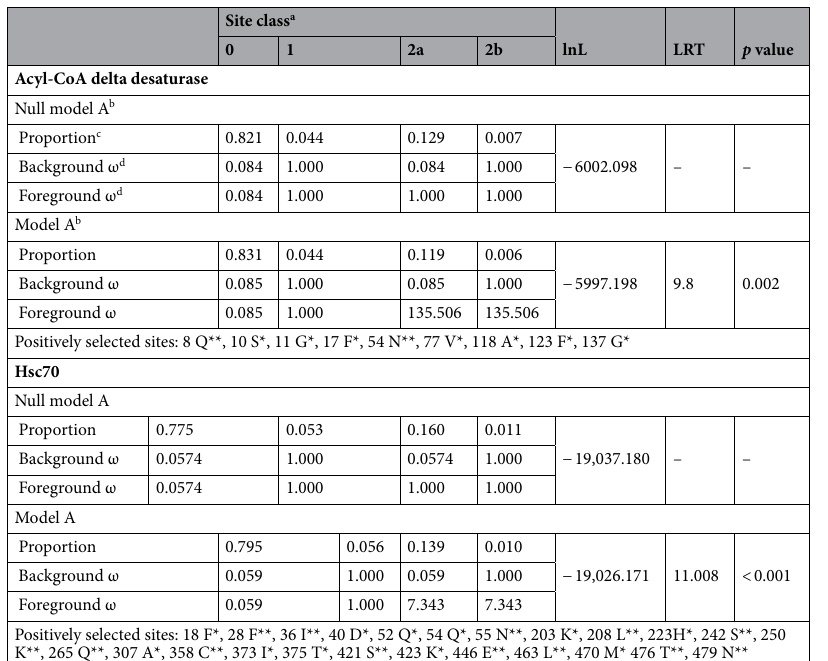
Table 3. Branch-site test of positive selection on P. steinenii -specific acyl-CoA delta desaturase and Hsc70. All p values were calculated using InL and LRT values and adjusted using the FDR (** p -value < 0.01 and * p value < 0.05). a Branch-site model for both gene families is run under the assumption of four site classes: class 0 = sites under negative selection in all gene family branches; class 1 = sites evolving neutrally in all gene family branches; class 2a = sites positively selected at P. steinenii -specific gene family branches, but negatively selected at other orthologous gene family branches; class 2b = sites positively selected on P. steinenii -specific gene family branches, but neutrally evolving on other orthologous gene family branches. b The branch-site model are defined two types of model: Model A allowing positive selection along P. steinenii -specific gene family branches; Null Model A allowing neutral evolution and negative selection. c The proportion indicates the fraction of sites within the gene family that belongs to each of the four site classes. d Foreground and background ω are the dN/dS ratio for the P. steinenii -specific gene family branches and all other orthologous gene family branches,